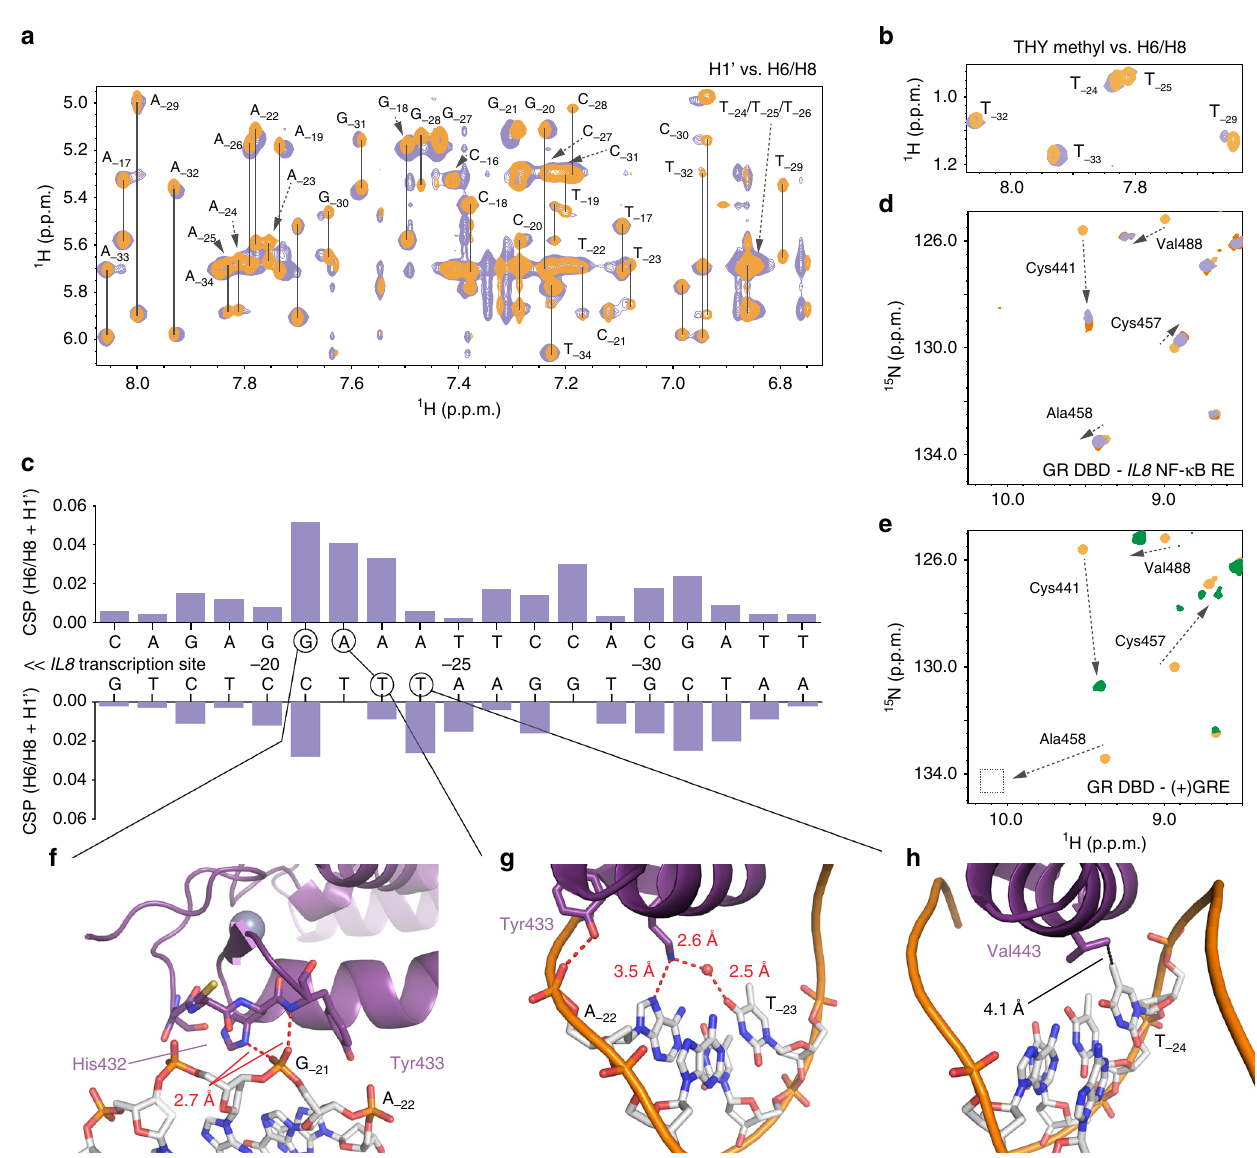
Fig. 5 NMR reveals an interaction footprint of the GR DBD- IL8 NF- κ B response element complex that is consistent with crystal structures. a , b 2D homonuclear [ 1 H, 1 H]-NOESY NMR data for IL8 NF- κ B response element alone (orange) or bound to GR DBD (2.3:1 molar ratio, purple). c NMR chemical shift perturbation analysis for data shown in a . f – h Show insets of highly perturbed bases. d 2D [ 1 H, 15 N]-HSQC NMR analysis of 15 N-labeled GR DBD (orange) and the same bound to IL8 NF- κ B response element (0.44:1 molar ratio, dark orange; 2.3:1 molar ratio, purple). e 2D [ 1 H, 15 N]-HSQC NMR analysis of 15 N-GR DBD (orange) and the same bound to ( + )GRE consensus DNA response element (green). f Base G -21 , which makes two close contacts with the GR DBD, is highly perturbed upon formation of the complex. The same is true of bases A -22 ( g ) and T -24 ( h